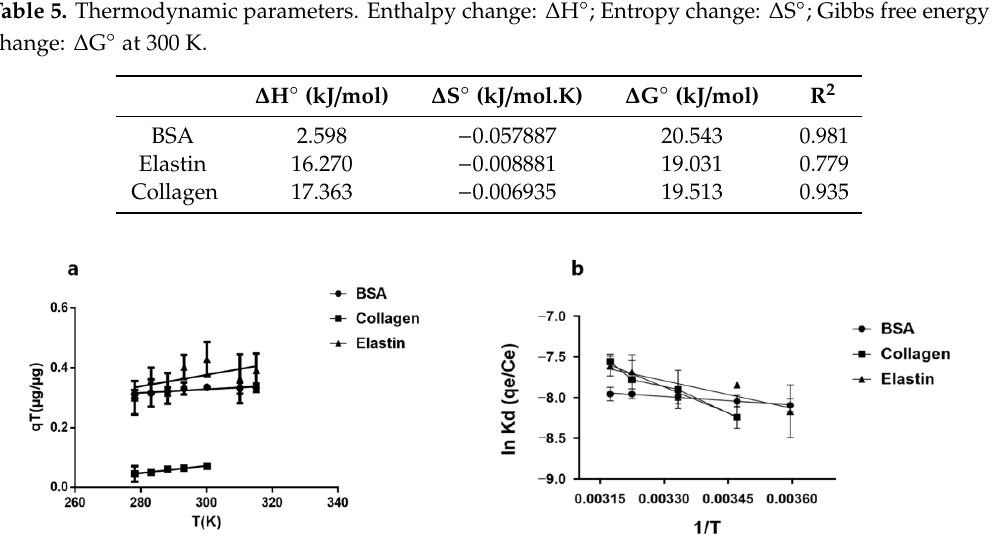
Figure 6. ( a ) Effect of temperature on adsorption capacity of BSA, collagen and elastin onto GO platelets surface. ( b ) van ’ t Hoff plot: K d : equilibrium constant; T: absolute temperature in K.